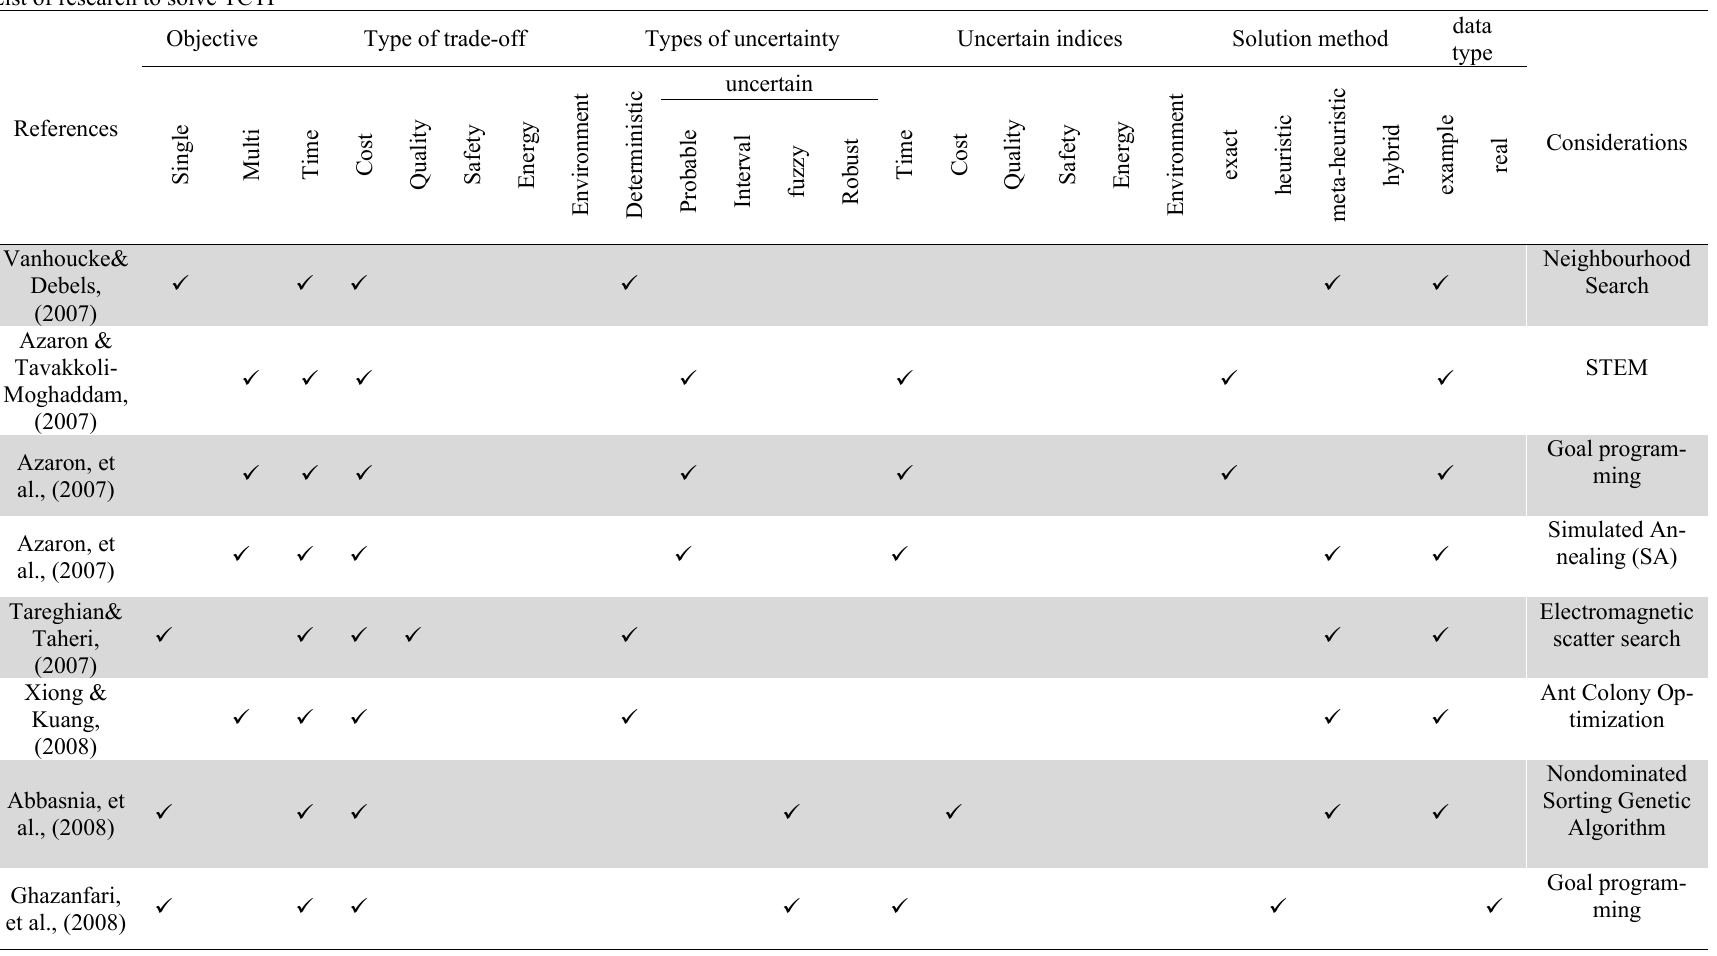
Table 1 List of research to solve